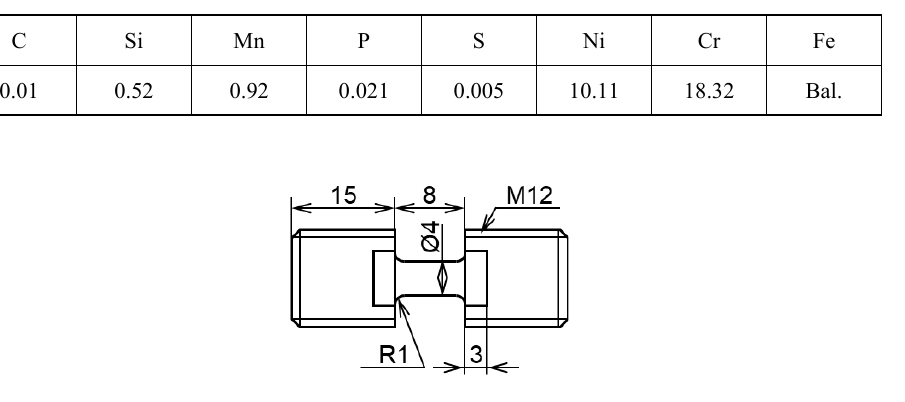
Fig. 1. Shape and dimensions of tensile test specimen (unit: